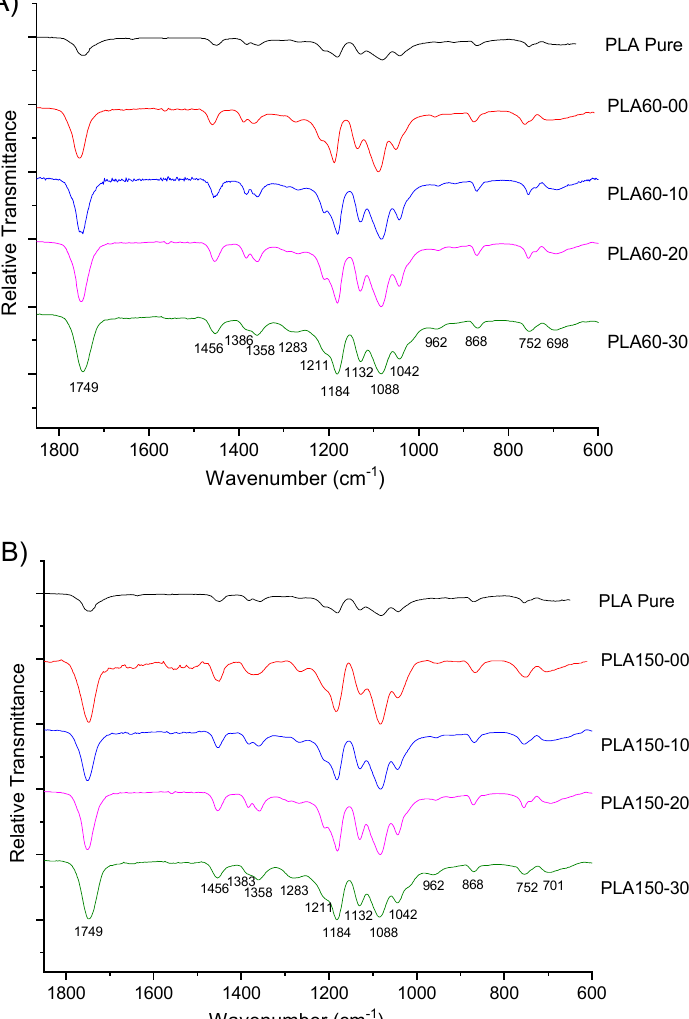
/ ATBC samples: ( A ) 60 and ( B ) 150